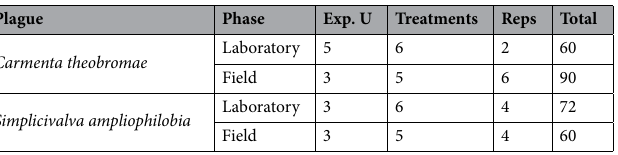
Table 2. Experimental design. Exp. U. : experimental unit (number of larvae), Reps .: repetitions. Source : Pulido Blanco (2020).